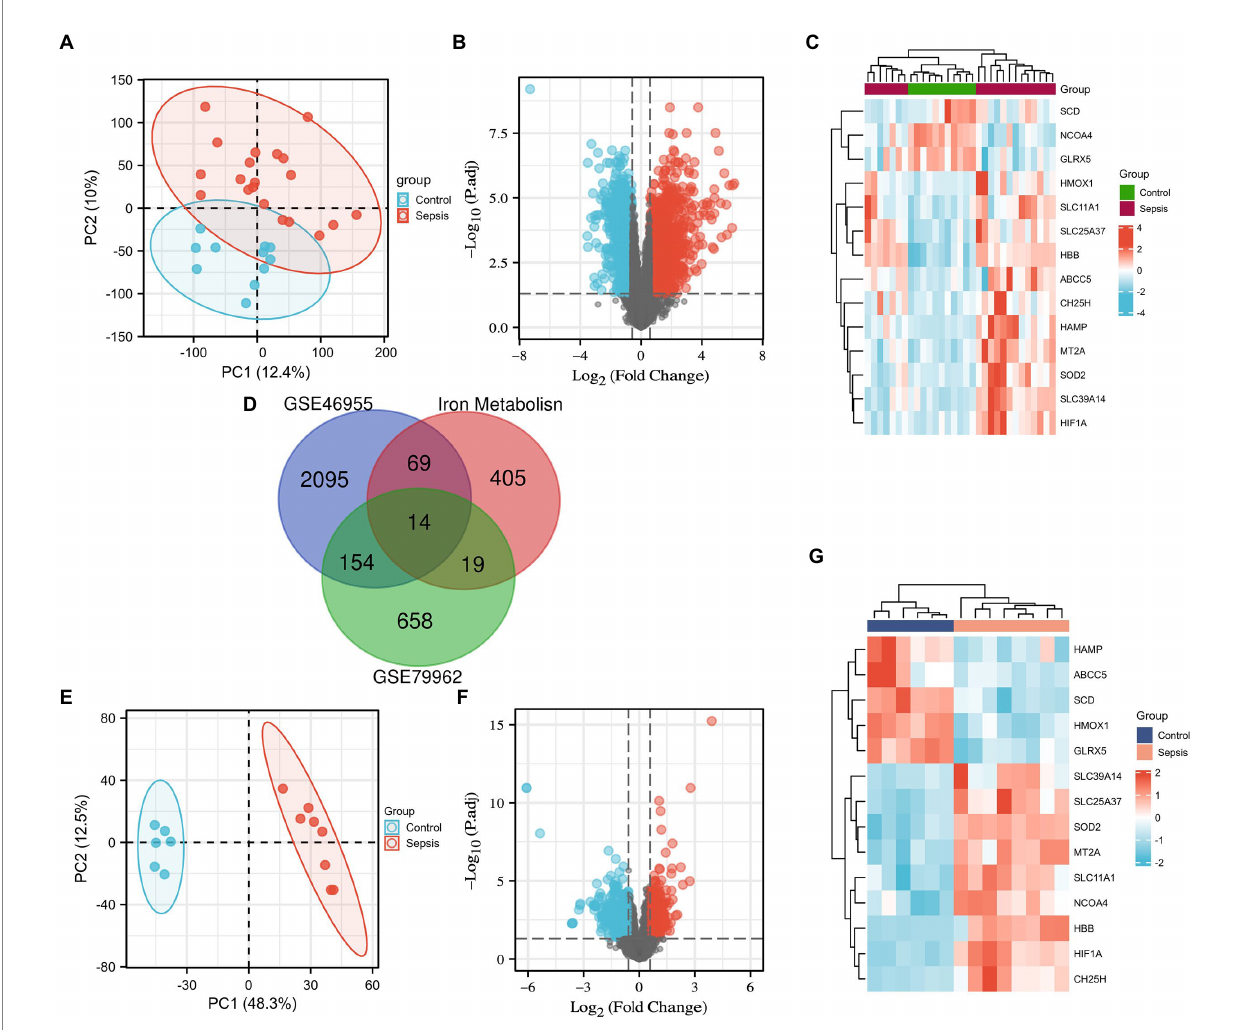
FIGURE 1 Screening of the differentially expressed iron metabolism-related genes (IMRGs). (A) Principal components analysis for GSE79962. (B) Volcano plot of GSE79962. (C) Heatmap of the common differentially expressed IMRGs in septic myocardiopathy and controls. (D) Venn diagram showing the overlap of genes among differentially expressed genes (DEGs) of GSE79962, GSE46955, and IMRGs. (E) Principal components analysis of GSE46955. (F) Volcano plot of GSE46955. (G) Heatmap of the common differentially expressed IMRGs in blood monocytes of sepsis and control